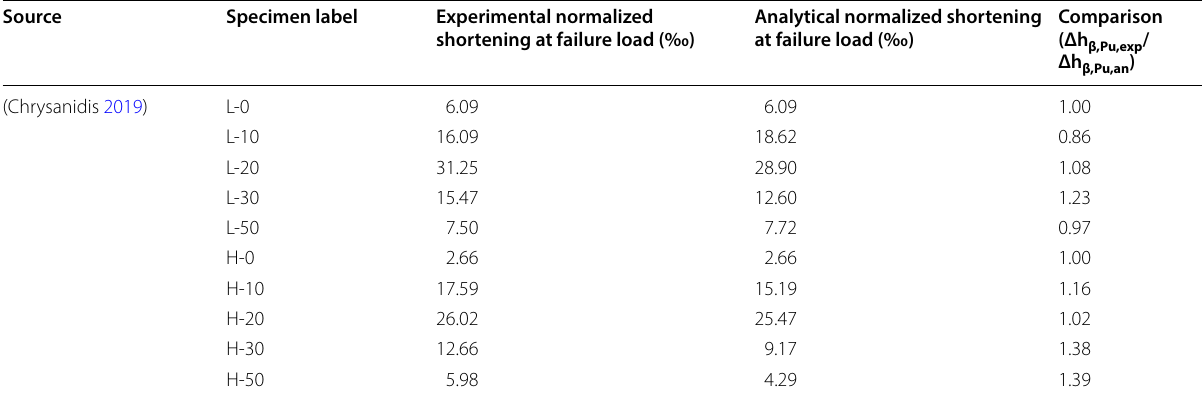
Table 11 Comparison between measured and empirical normalized shortening at maximum failure load (bibliography). Source Specimen